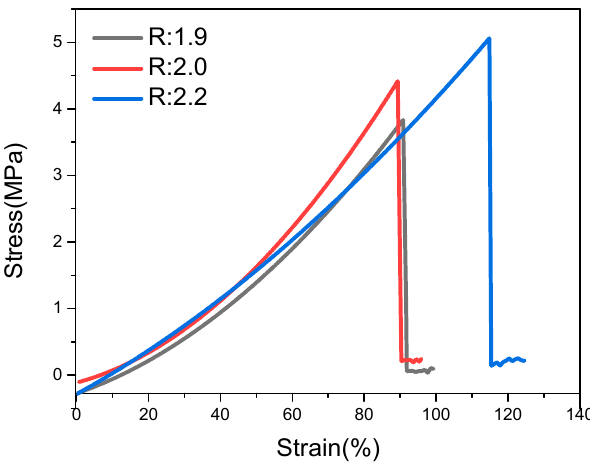
Figure 7. R -value effect on tensile properties of PU-TiO 2 composite film.